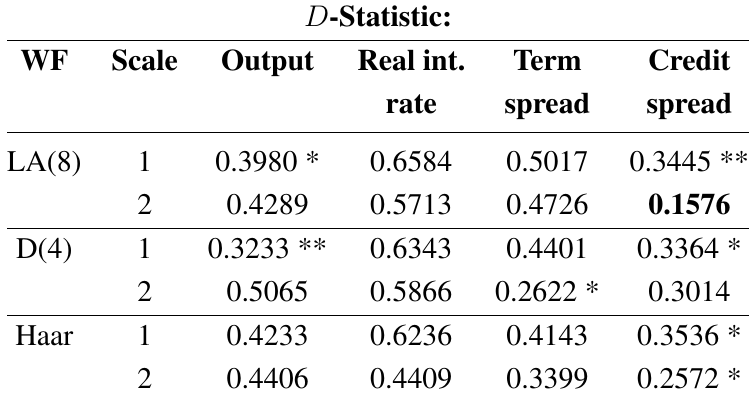
Table 3. Results of testing for homogeneity of variance using the LA(8), D(4) and Haar wavelet